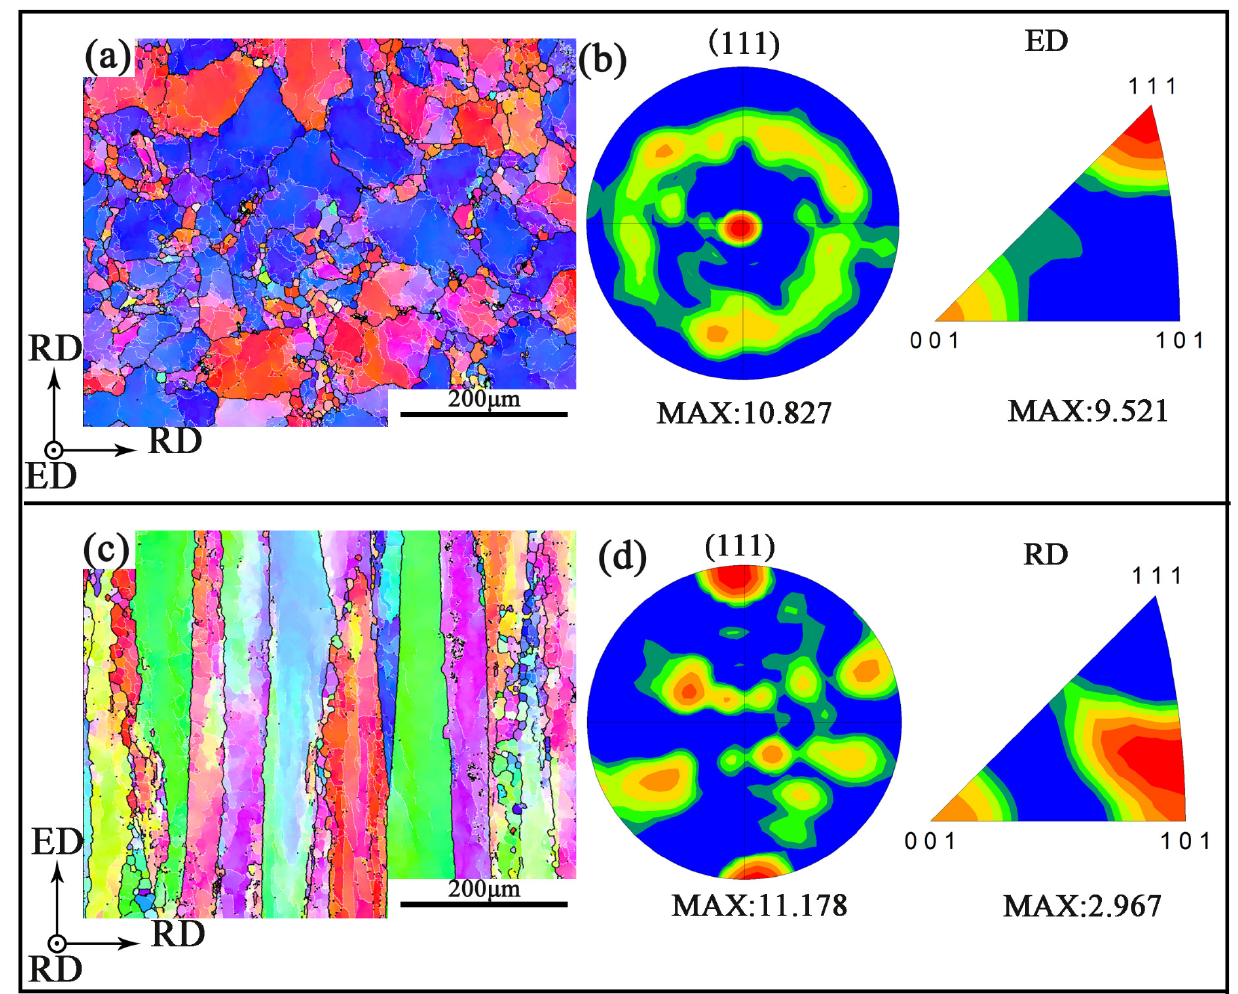
Figure 4. The inverse pole figure (IPF) and the corresponding (111) pole figure (PF) of the specimens. ( a , b ) RD-RD. ( c , d ) ED-RD.